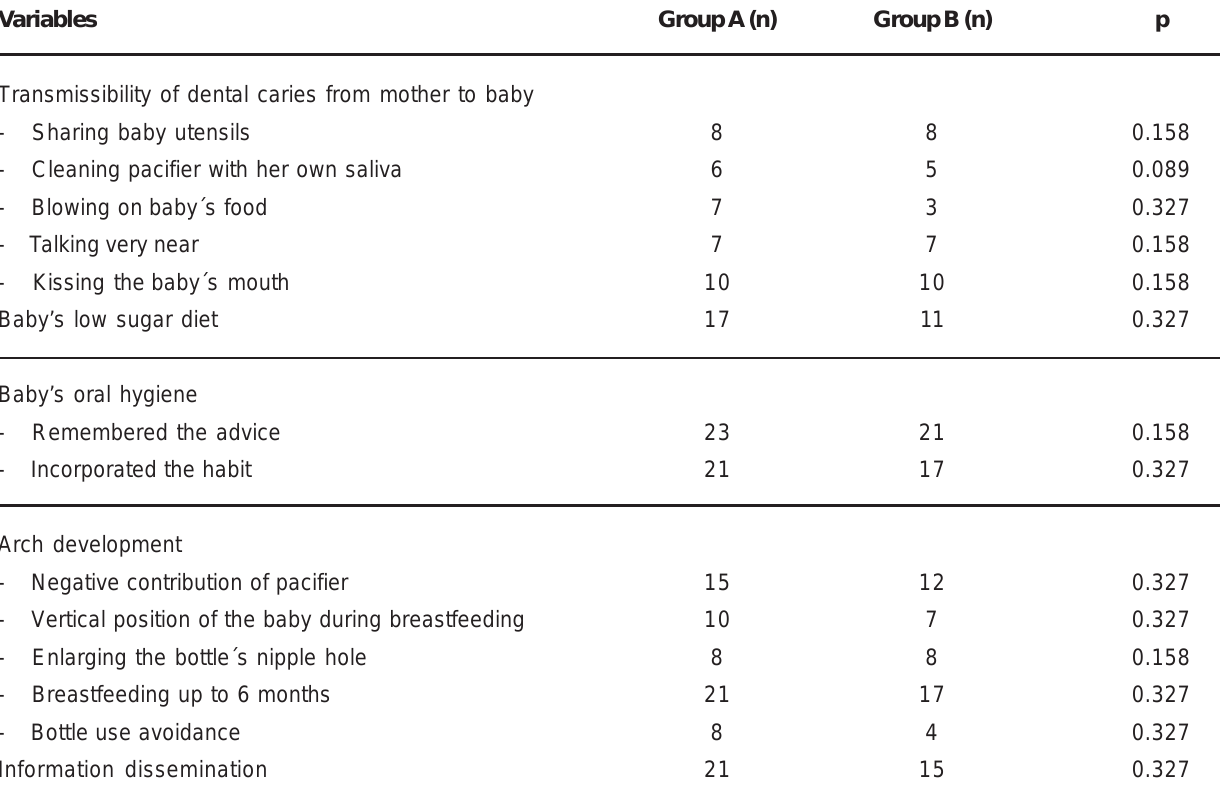
TABLE 1- Mothers’ recall of baby oral health instructions received in their lying-in